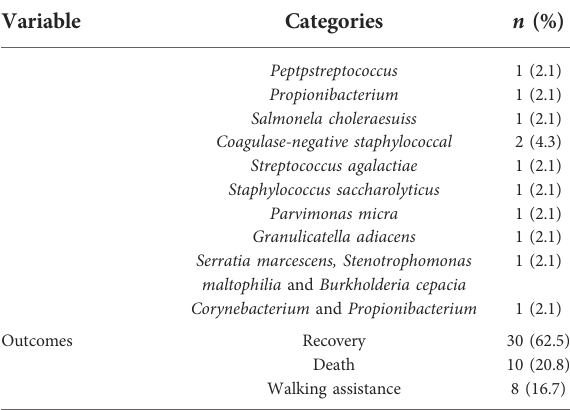
and bone graft fusion. The remaining 3 patients were treated by